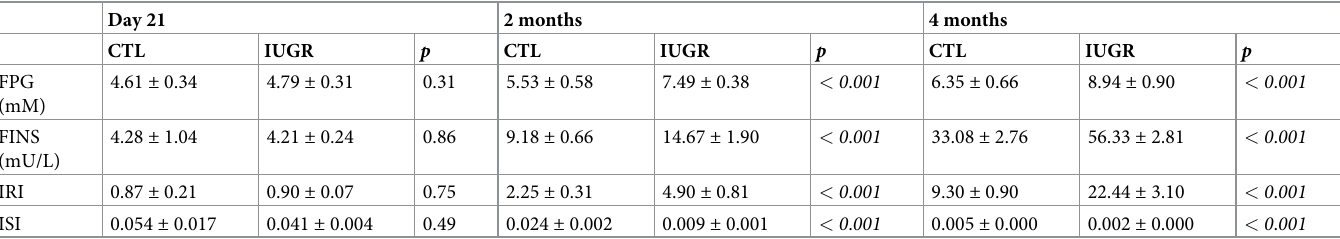
Table 2. Glucose metabolic indices in the controls and the IUGR offsprings.